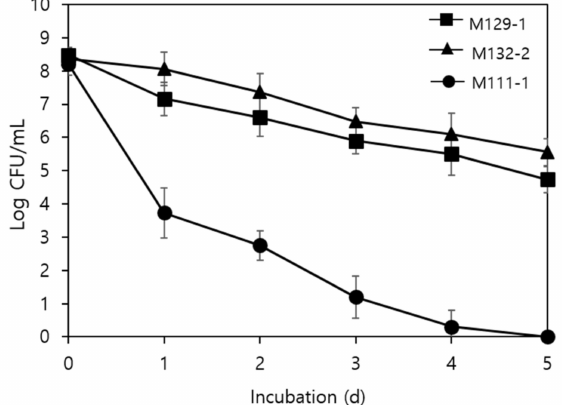
Figure 2. Survival of Lactobacillus sakei M129-1, Pediococcus pentosaceus M132-2, and Leuconostoc lactis M111-1 attached to SSCs under a desiccation environment (43% relative humidity, RH; 25 ◦ C). SSCs were incubated for up to 7